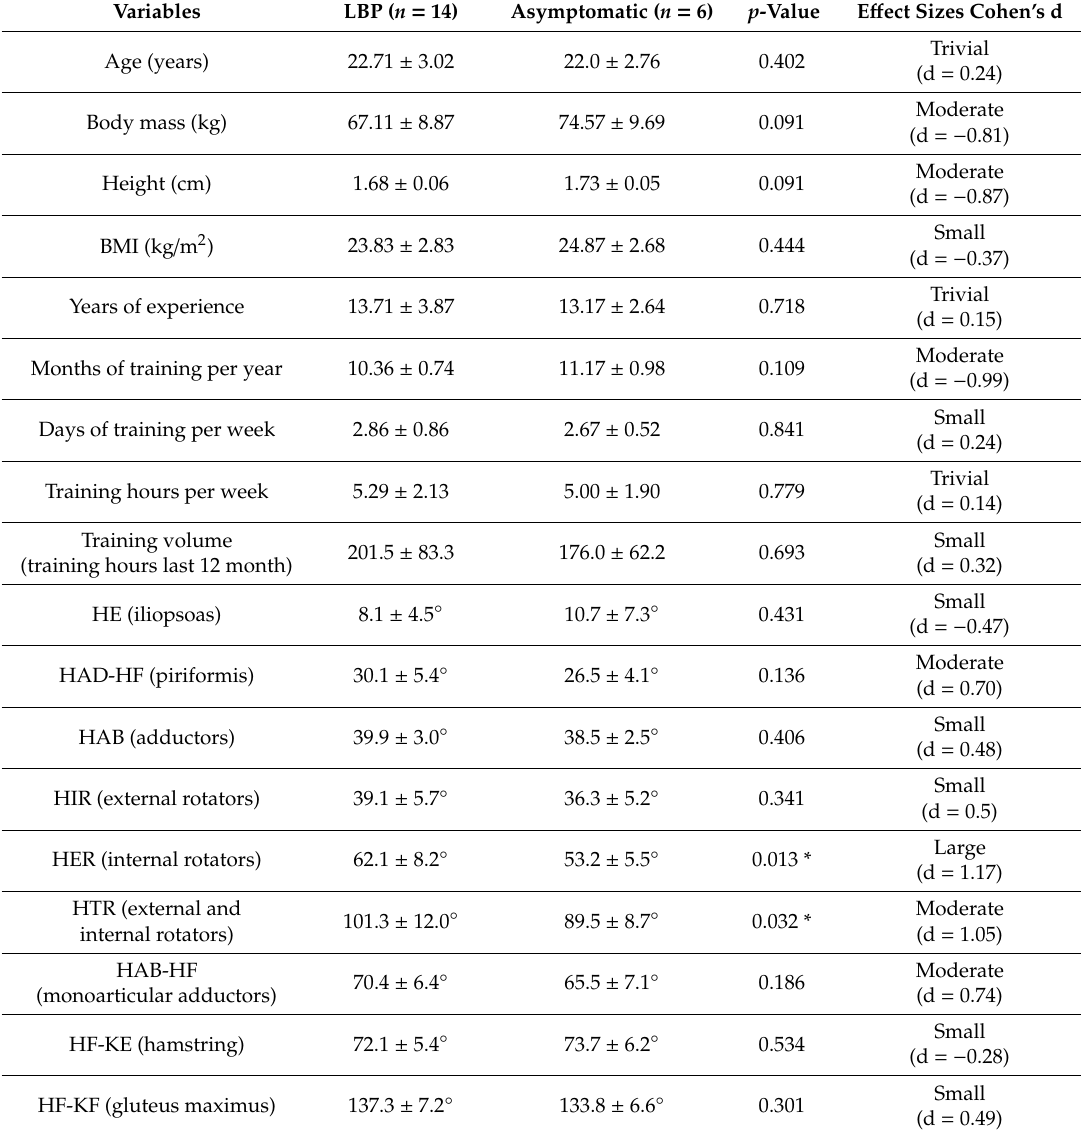
Table 3. Comparative analysis of studied variables between inline hockey players displaying LBP and asymptomatic